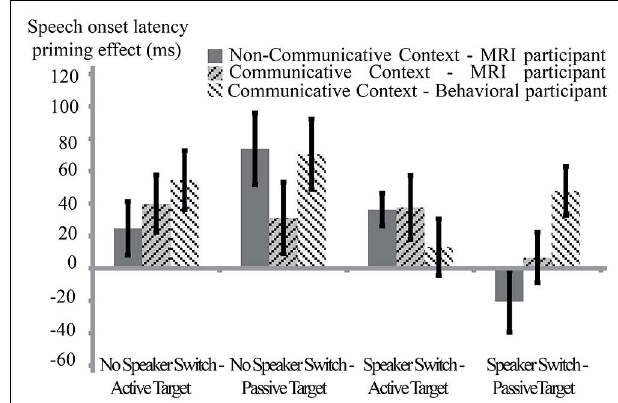
FIGURE 3 | Between-context analysis (1): behavioral results for three groups of participants. Speech onset latency-priming effects (novel – repeated syntax) in ms (error bars reflect standard errors), split by Speaker Switch (no speaker switch means production prime – production target; speaker switch means comprehension prime – production target) and Target Structure (active or passive voice). Dark-gray bars with solid fill represent the average priming effect of the MRI participants in the non-communicative condition. Of the two bars with striped pattern fill, the darkest gray bar represents the MRI participants in the communicative context and the lighter gray bar represents behavioral participants in the communicative condition.There were speech onset latency-priming effects in the two communicative as well as in the non-communicative condition.